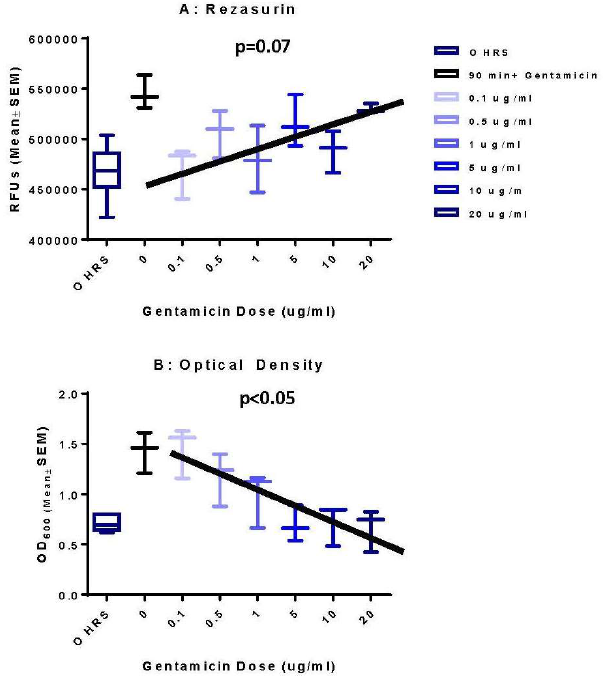
Figure 11. Cellular metabolic activity of M. avium with gentamicin treatment at time zero and 90 h. ( A ) Increased activity after 90 h was significant for 0, 0.5, and 20 µg/mL at * p < 0.05 and for 5 µg/mL at ** p < 0.01 according to two-tailed, paired T -test analysis when comparing to the initial 0-minute time point, n = 3. ( B ) The cyclic nature of the metabolism of M. avium over the course of the study in the presence and absence of the dose escalation of gentamicin. The blue line is without gentamicin, the red line is with the 20 µg/mL gentamicin